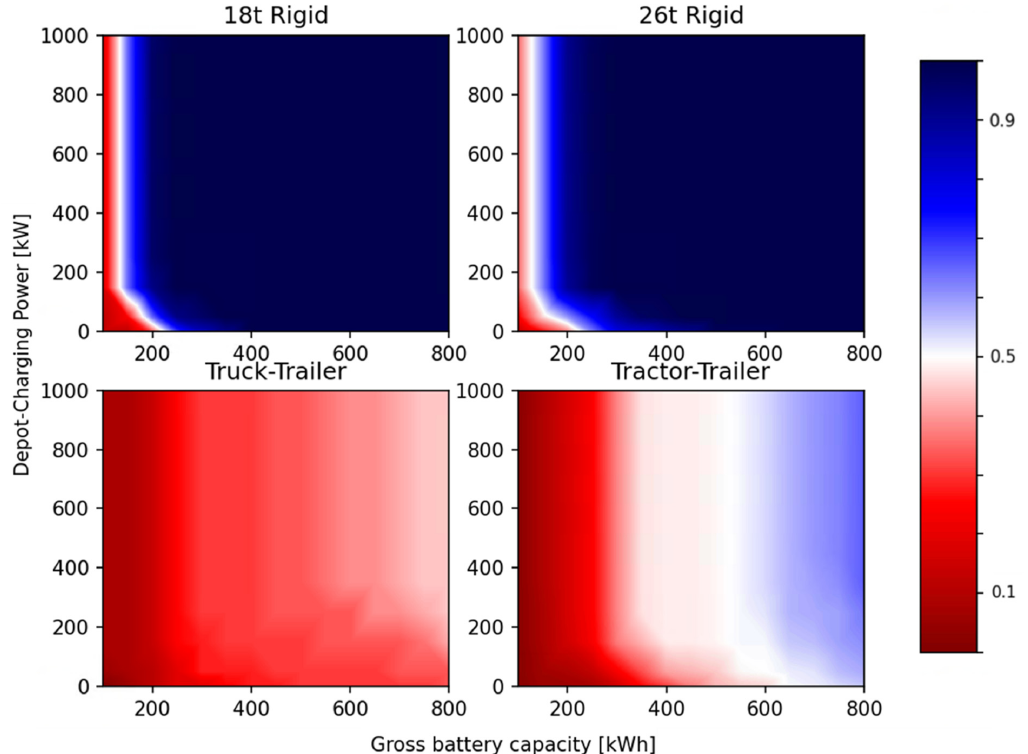
Figure 7. BET feasibility per truck class—scenario 1. Variations for battery capacity [kWh] and depot-charging power [kW]; color bar indicates technical feasibility from 0% to 100%—own illustration.